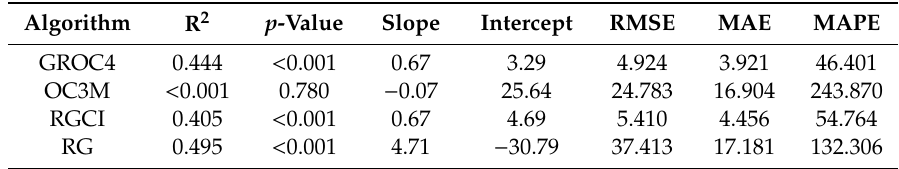
Table 5. Statistics comparing the performance of GROC4 algorithm to that of the OC3M, RGCI and RG algorithms.